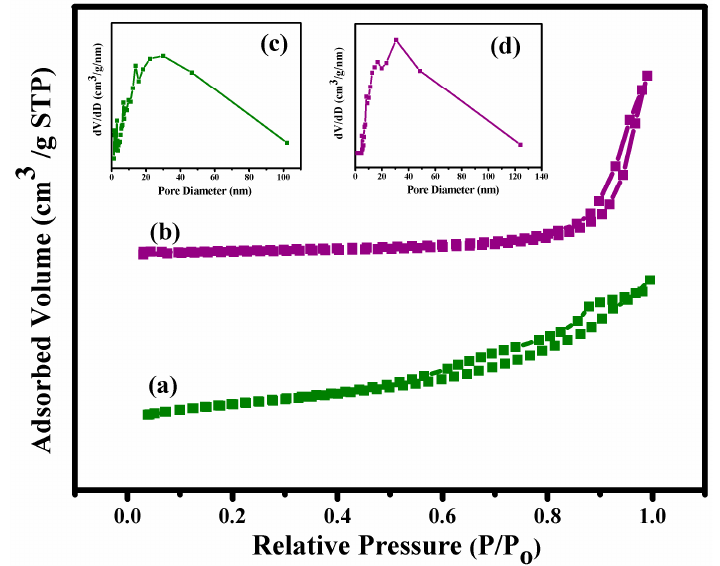
Figure 4. ( a ) Nitrogen (N 2 )-adsorption/desorption isotherms of Fe 3 O 4 nanoparticles, and ( b ) Fe 3 O 4 /HAp nanocomposite. Inset Figure ( c , d ) shows the pore-size distribution of the Fe 3 O 4 nanoparticles and Fe 3 O 4 /HAp nanocomposite, respectively.